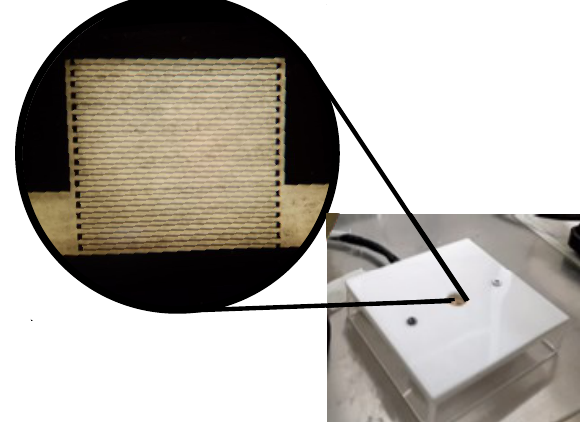
Fig.1: Interdigitated array microelectrodes consisting of a gold film embedded on a glass surface. EBiS measurements were performed on a 1 μ L DNA drop.